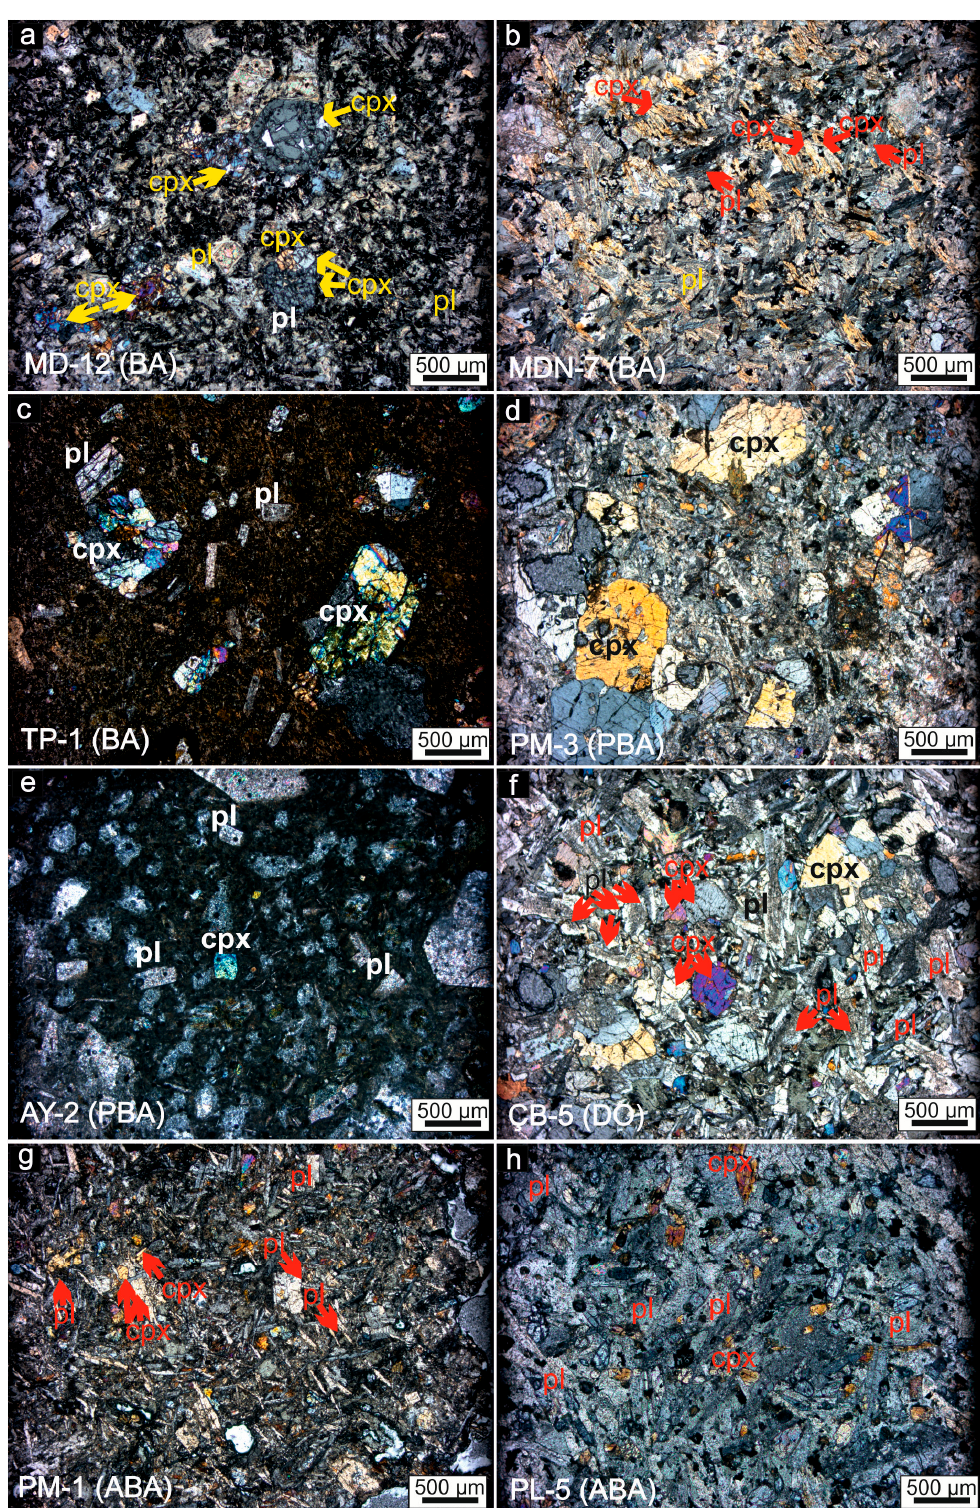
Figure 4. Microphotographs of mineralogical and textural characteristics of the investigated samples from the Yüksekova Complex. ( a ) Basalt (BA, sample MD-12); ( b ) Basalt (BA, sample MDN-7); ( c ) Basalt (BA, sample TP-1); ( d ) Porphyric basalt (PBA, sample PM-3); ( e ) Porphyric basalt (PBA, sample AY-2); ( f ) Dolerite (DO, sample ÇB-5); ( g ) Anorogenic basalt (ABA, sample PM-1), ( h ) Anorogenic basalt (ABA, sample PL-5)). Cpx: clinopyroxene, pl: plagioclase.